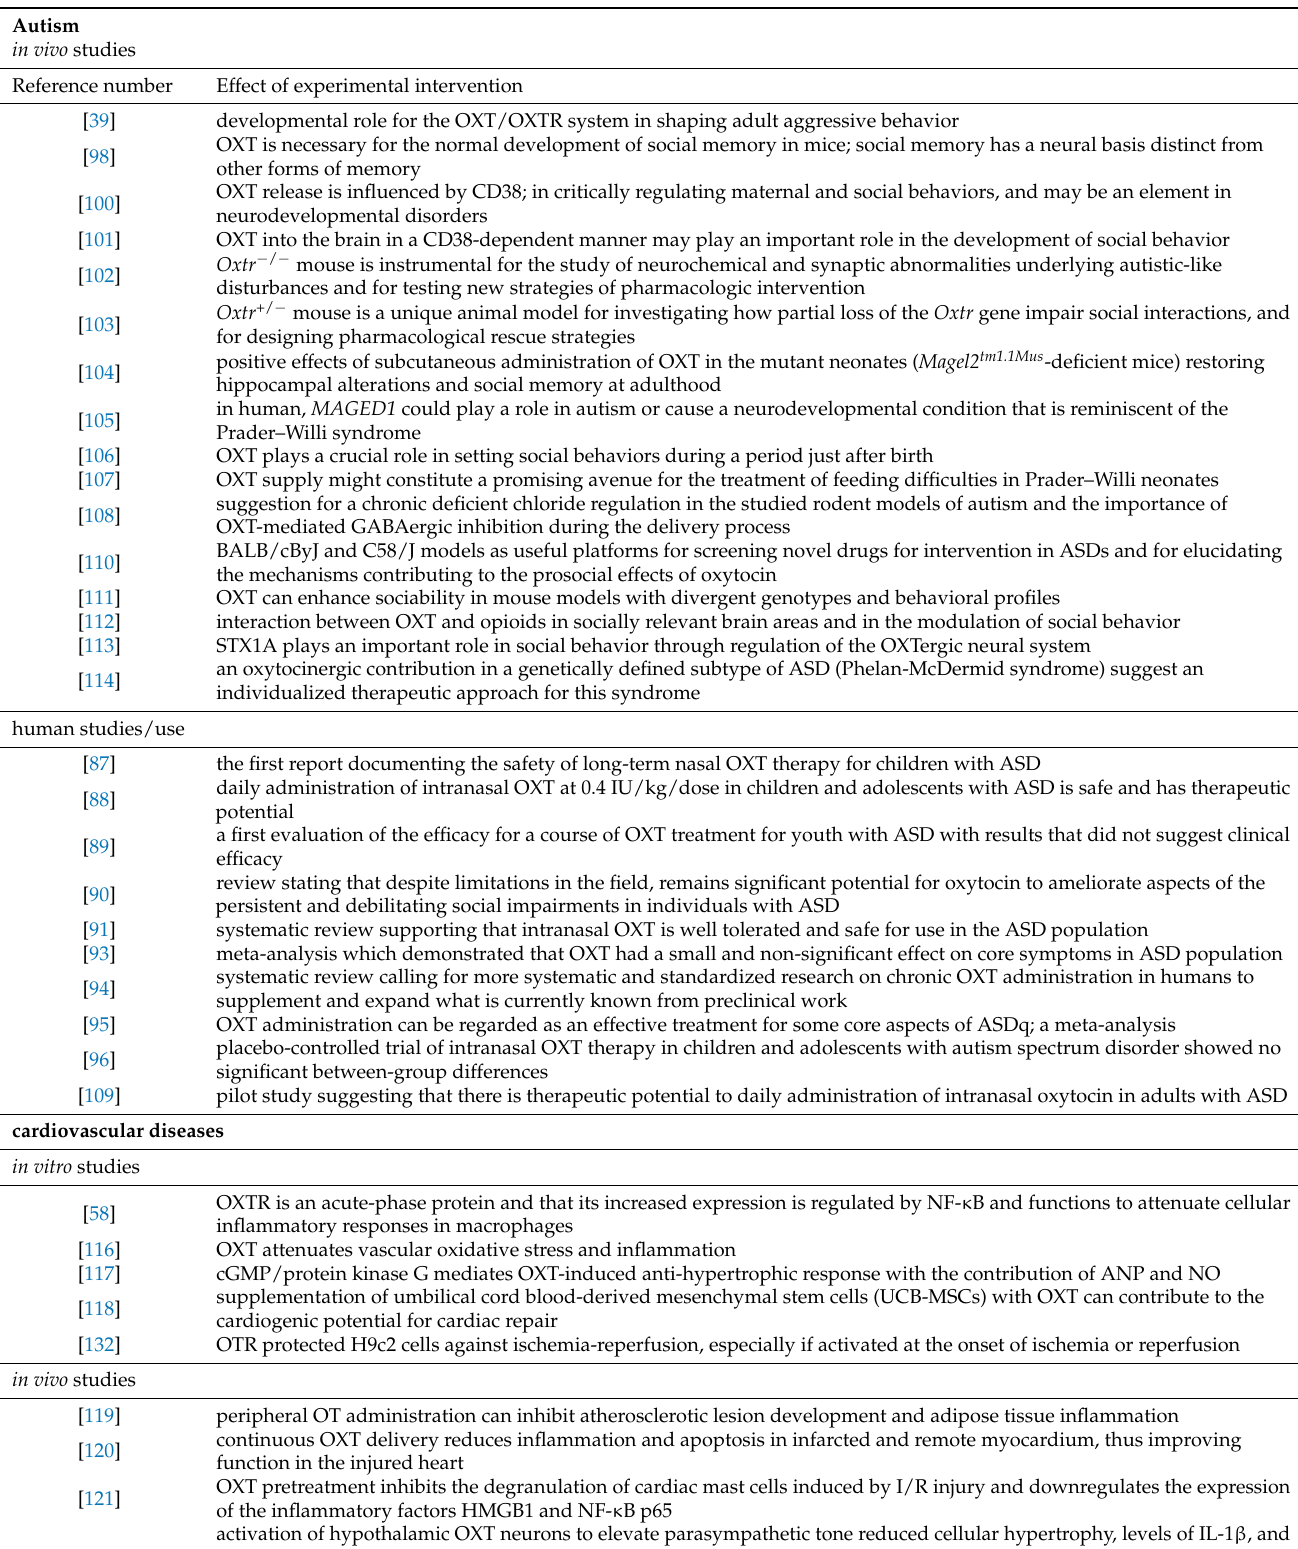
Table 2. List of the studies ( in vitro , in vivo , ex vivo and human) presented in Table 1 with related result of oxytocin intervention and/or treatment of degenerative